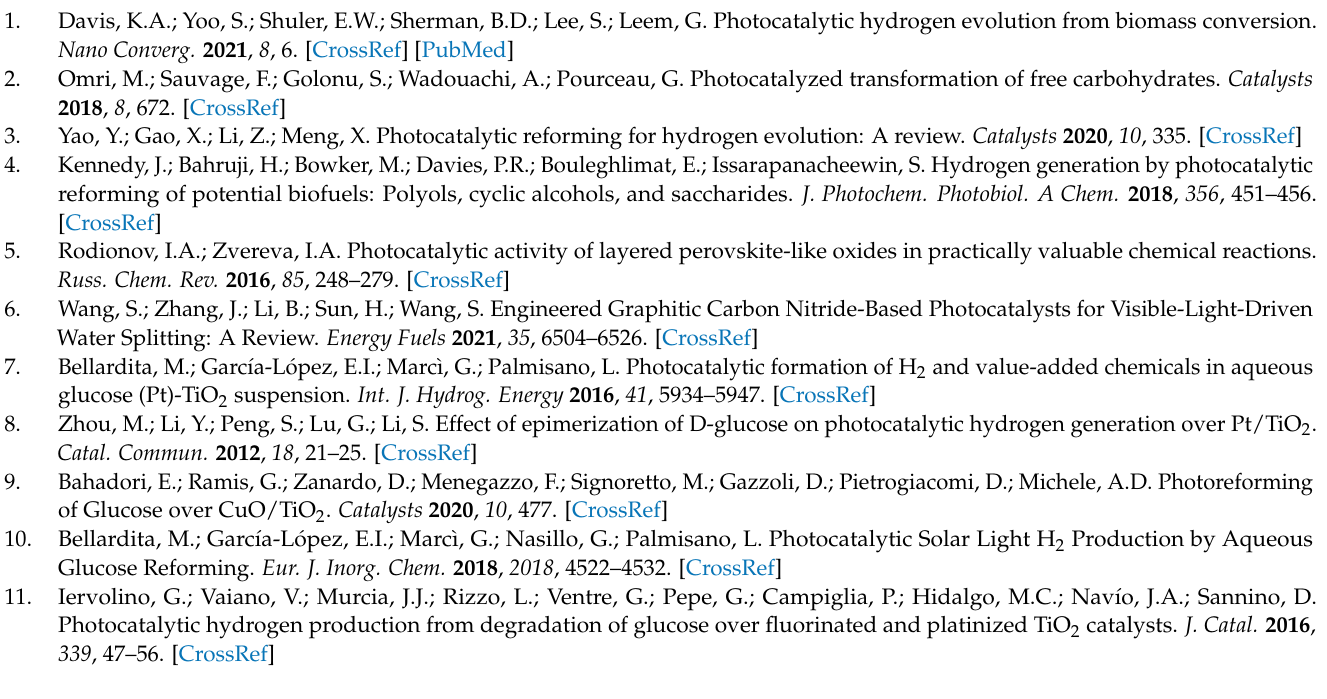
Table S1: Actual volume concentrations of the samples in suspensions and pH of the reaction medium, Figure S7: Comparison of the actual concentrations of the samples in the reaction suspensions at the beginning and the end of the photocatalytic